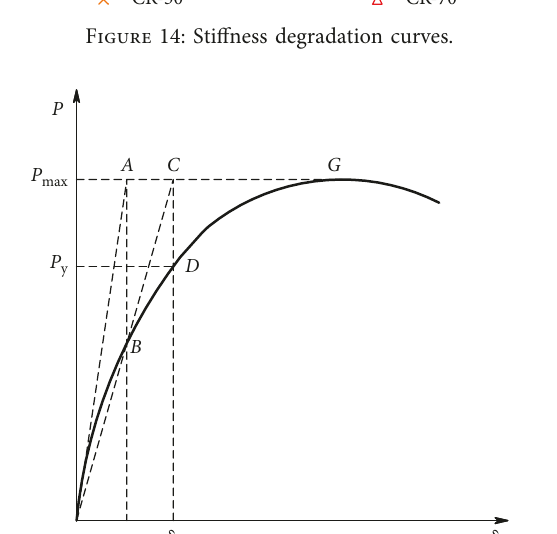
Figure 14: Stiffness degradation